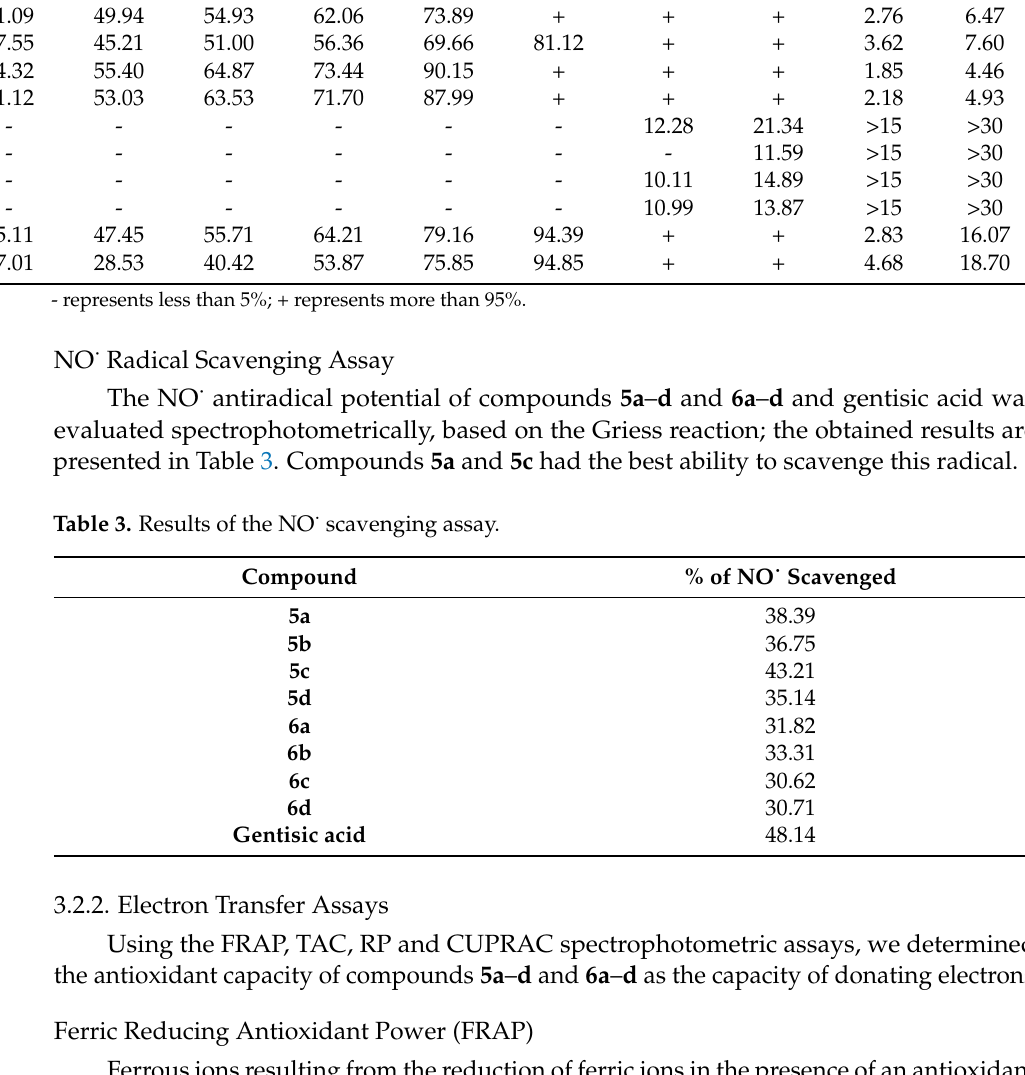
Table 4. Compounds 5a , 5c and 5d expressed a good electron donation